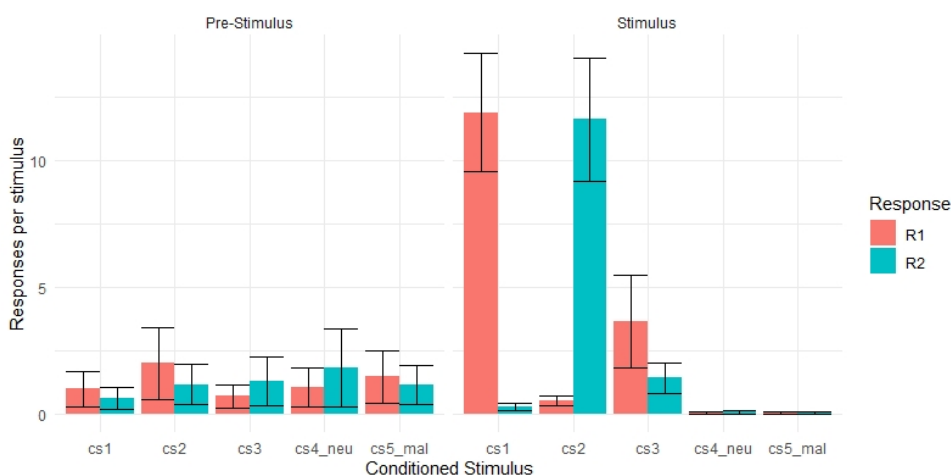
Figure 3. Number of responses per stimulus, by trial type, during the transfer phase. Specific transfer was observed; CS1 was associated with increased instrumental responding of R1 compared to R2 and compared to the pre-stimulus period. CS2 was associated with increased instrumental responding of R2 compared to R1 and compared to the pre-stimulus period (all p < 0.05). We did not observe a general transfer effect. CS3 did not increase R1 or R2 responding compared to the pre-stimulus period (all p > 0.05). Error bars represent standard error of the mean.